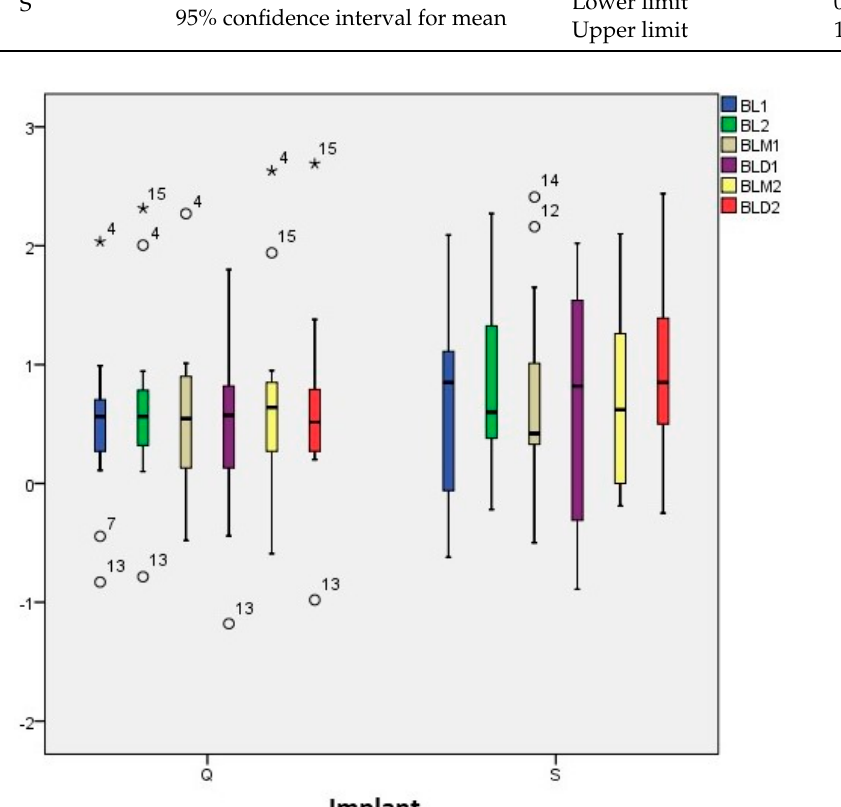
Figure 3. Box plot of bone level measured at 3 months and 5 years, grouped according to implant type. S = Standard implant, Q = Quattro implant. O = Outliers. * = Extreme outliers. The results for the marginal B.L. are shown in Tables 1 and 2, and Figure